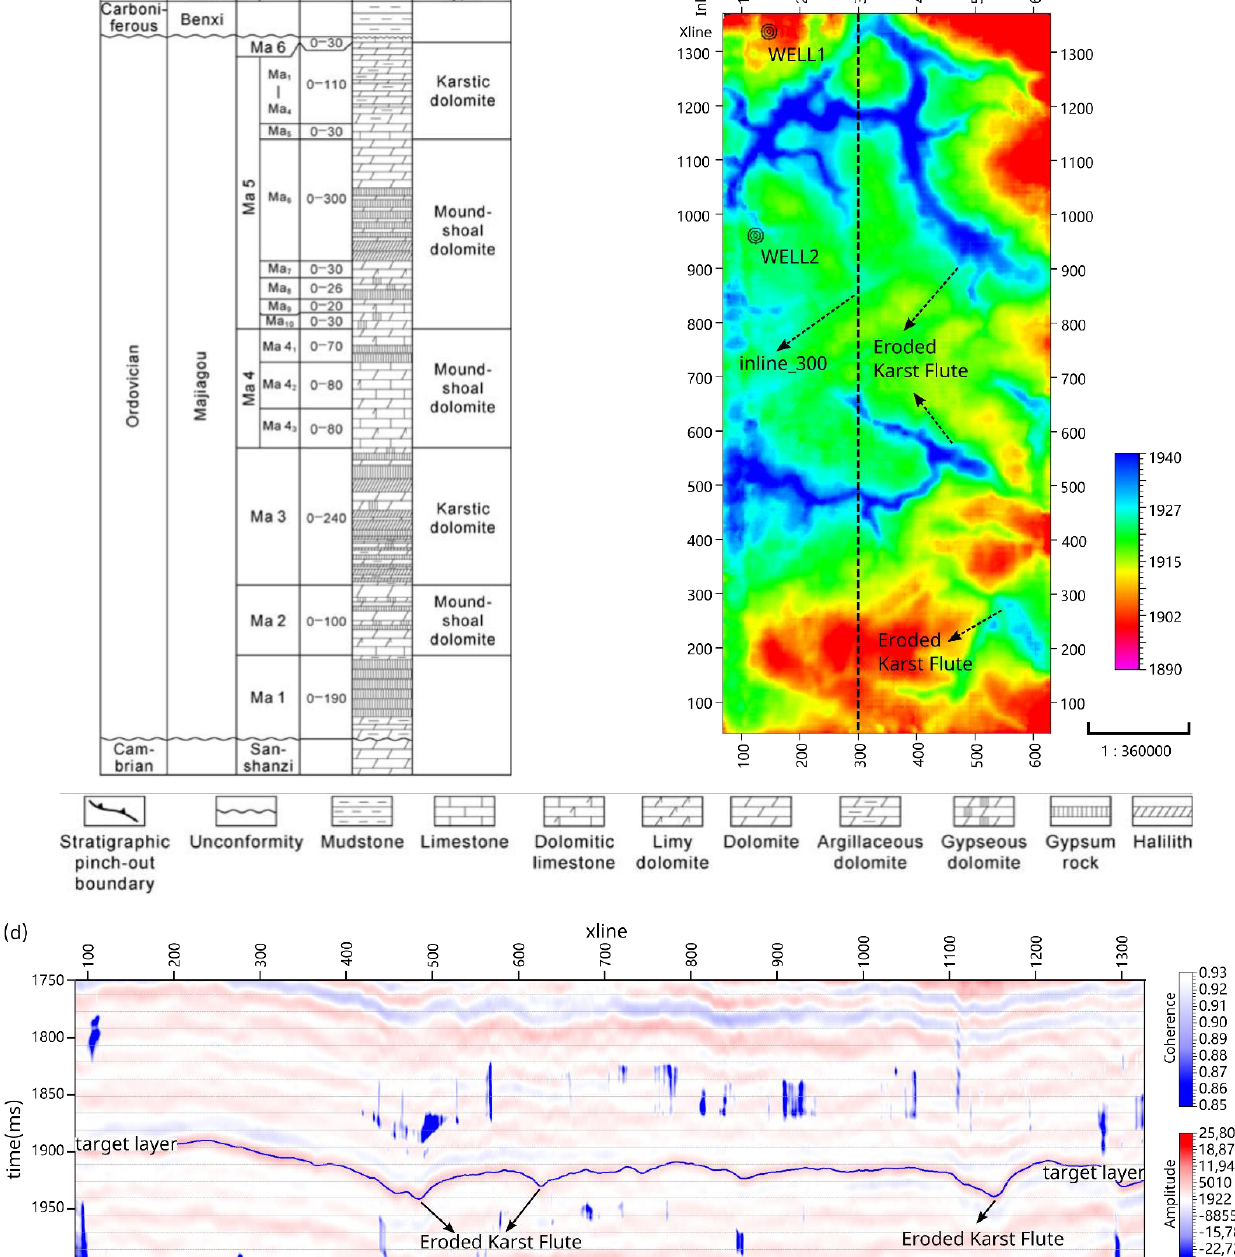
Figure 3. Target strata in the Majiagou Formation, Ordos Basin, China. ( a ) Tectonic framework and units of the basin (modified from reference [37]). The white area represents the young graben system around basin margins, and dark gray represents the deformation belts around the basin. 1. fault; 2. normal fault; 3. thrust fault; 4. strike-slip fault; 5. fold; 6. river; 7. city; 8. basin boundary; 9. tectonic unit boundary; 10. study area. ( b ) Comprehensive stratigraphic column of Ordovician Majiagou Formation obtained from previous studies [38]; ( c ) structure map of time domain for target layer; ( d ) profile of amplitude versus coherence for inline_300.